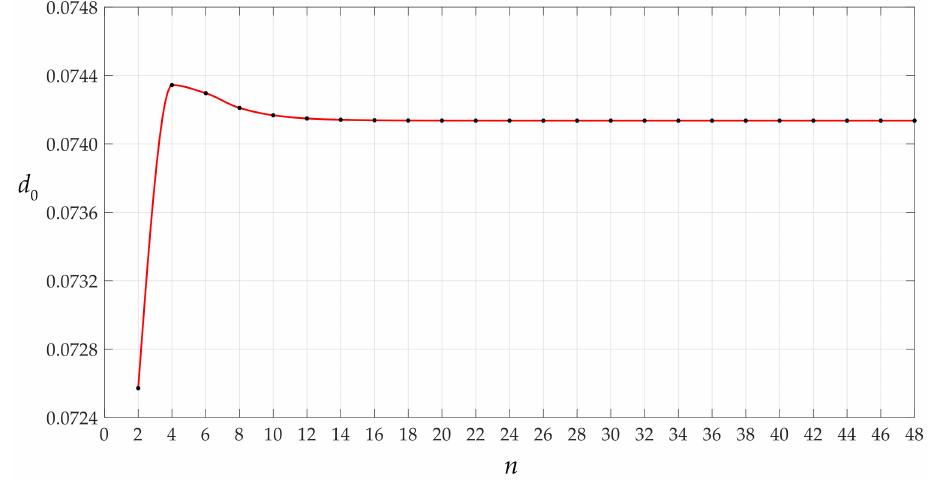
Figure 8. Variations of d 0 with n when q takes 0.00004 MPa.